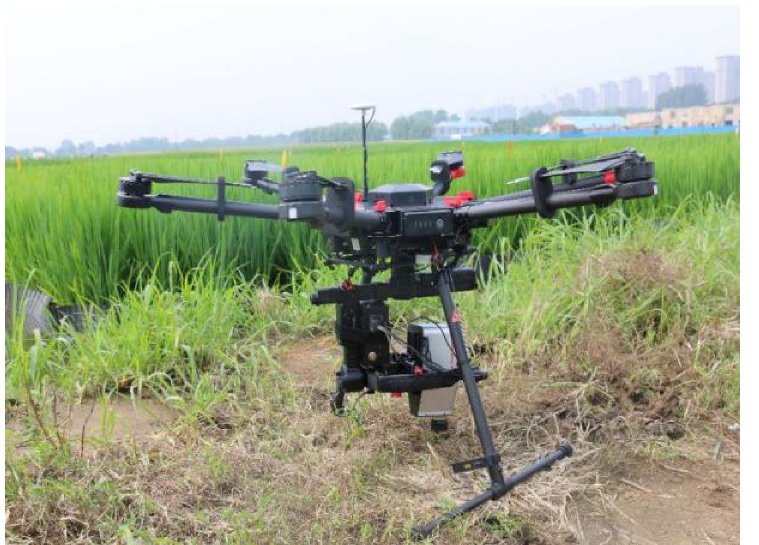
Fig 2. UAV hyperspectral imaging